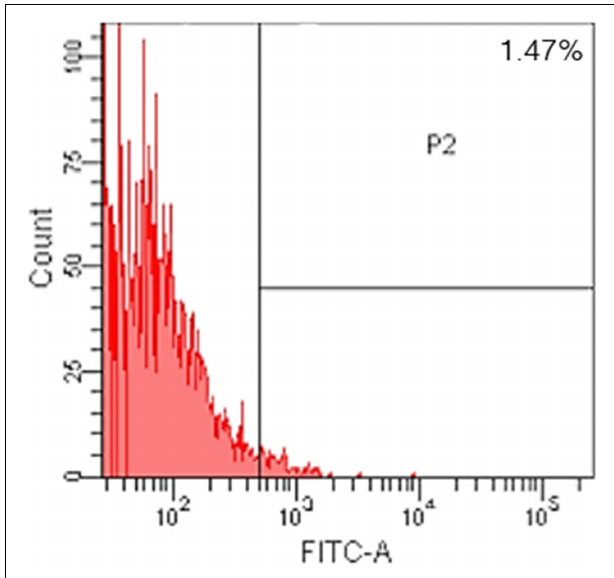
FIGURE 4 | Flow cytometry analysis of cAVM-ECs. Expression of CD31 in isolated human cAVM-ECs.